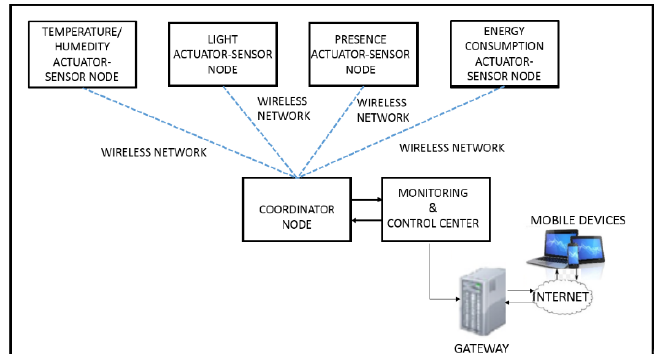
Figure 2. System Architecture.